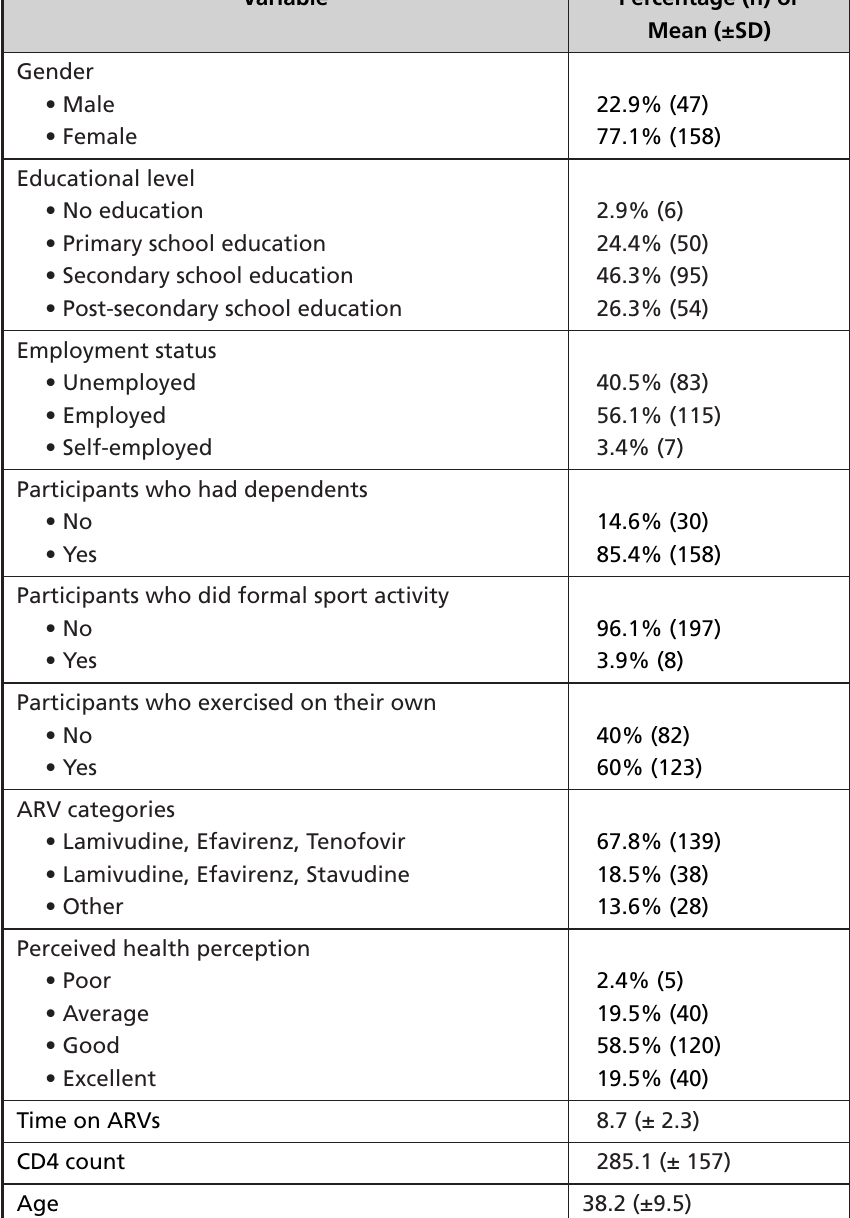
Table 1: Demographics of study participants (n = 205)